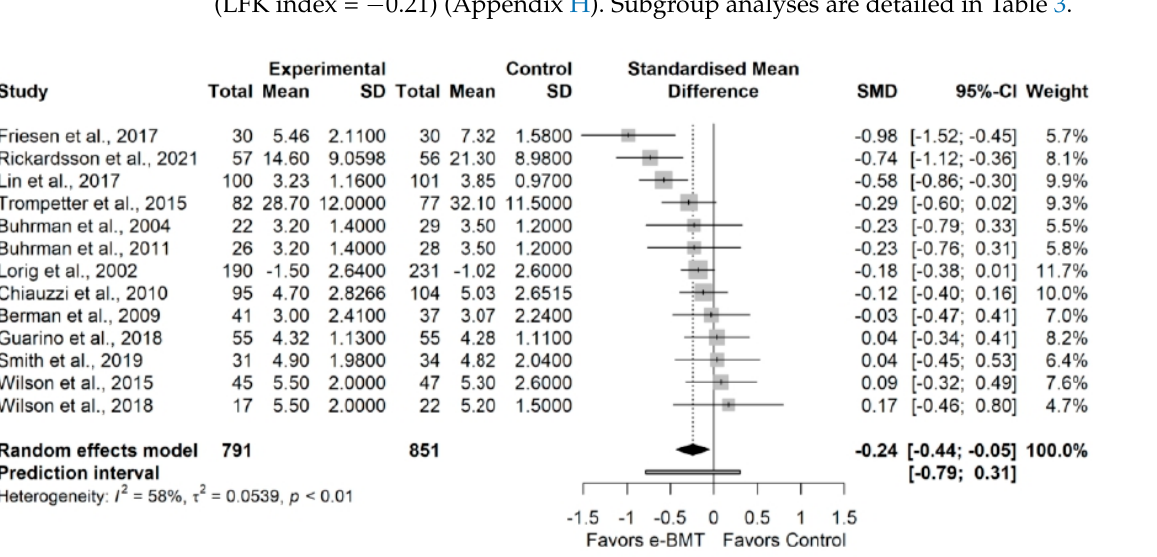
Figure 3. Synthesis forest plot of pain interference variable for online behavioral techniques against usual care or waiting list. The forest plot summarizes the results of included studies (sample size, mean, standard deviation (SD), standardized mean differences (SMDs), and weight). The small boxes with the squares represent the point estimate of the effect size and sample size. The lines on either side of the box represent a 95% confidence interval (CI).